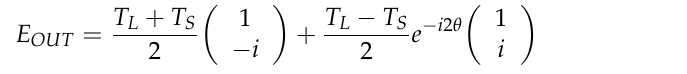
Table 2. The phase groups in 1/2 intensity under LCP light and RCP light.